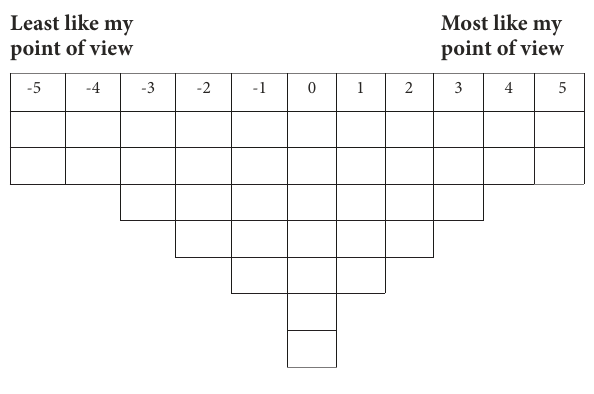
TABLE 3 Extract factors from the rotated factor matrix. Group